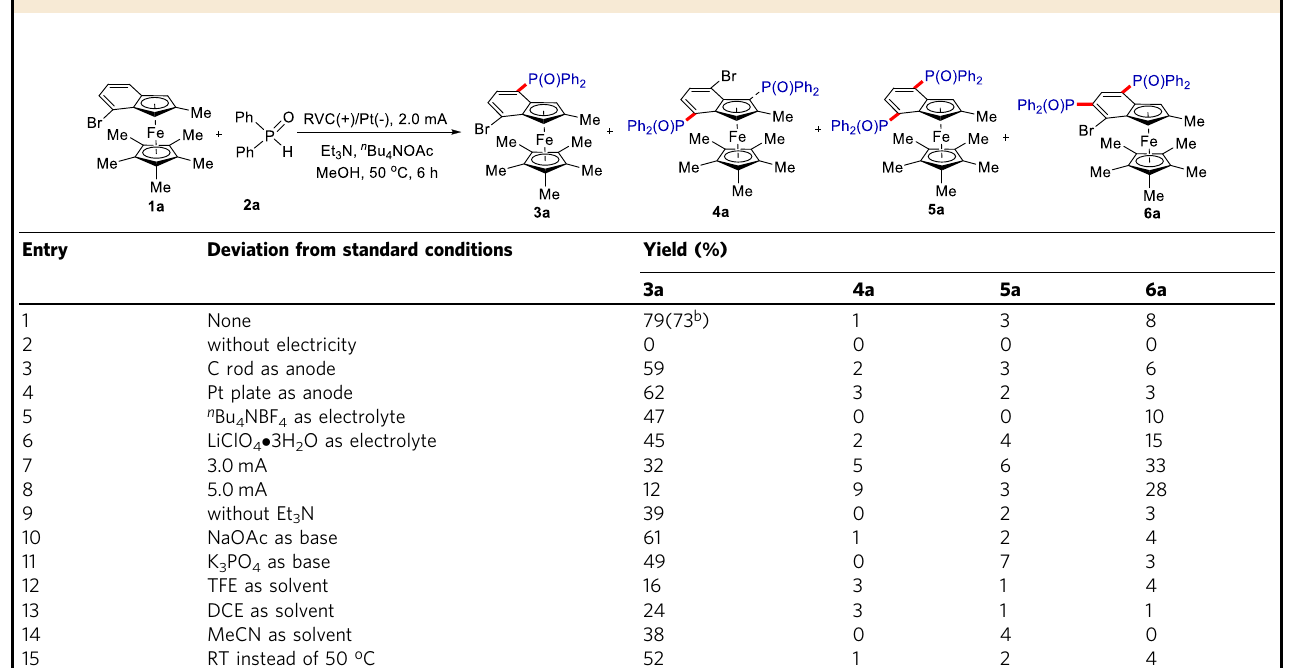
Table 1 Optimization of reaction conditions a